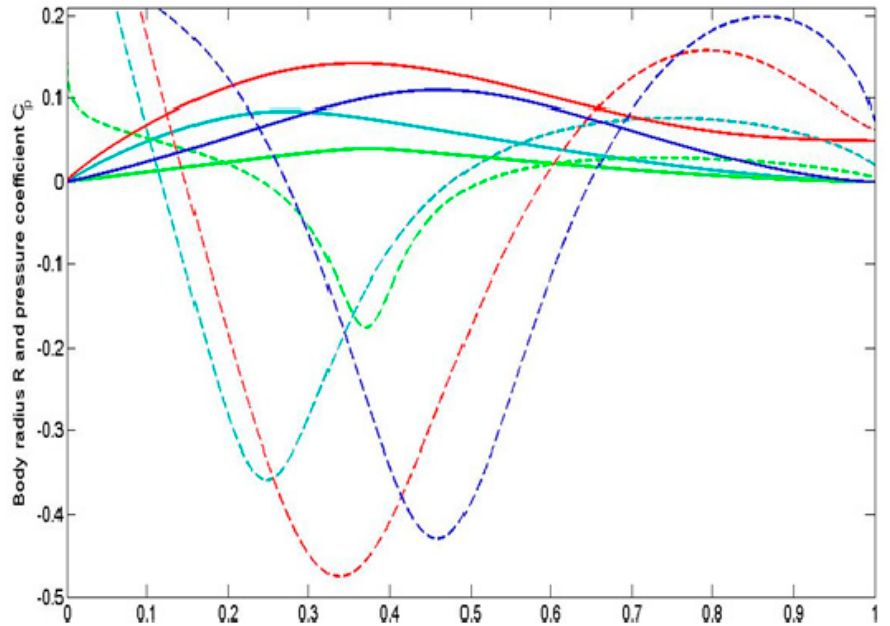
Figure 2. Specially shaped bodies of revolution, [22]. Radius R (solid lines) and pressure coefficient C P (dashed lines) versus dimensionless axis coordinate x/L . Unclosed body UA-2 without boundary layer separation ( L/D = 3.52; red lines). Closed bodies UA-4.5c “Albacore” ( L/D = 4.5; dark blue lines); UA-5.9c “Blue shark” ( L/D = 5.9; blue lines); UA-12.4c “Sailfish” ( L/D = 12.4; green lines).